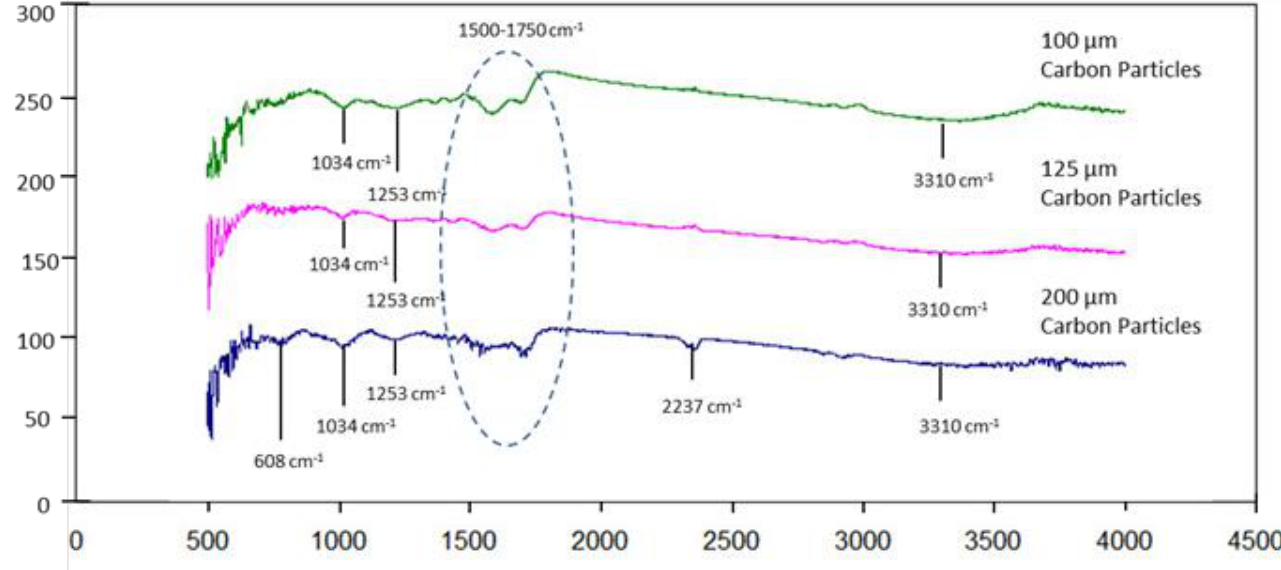
Fig. 4. FTIR analysis of carbon particles with different sizes from pineapple peel